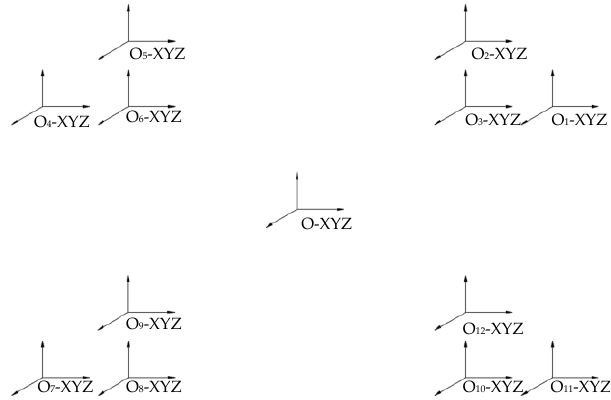
Figure 5. Coordinate system of a novel 6-DOF suspension platform.